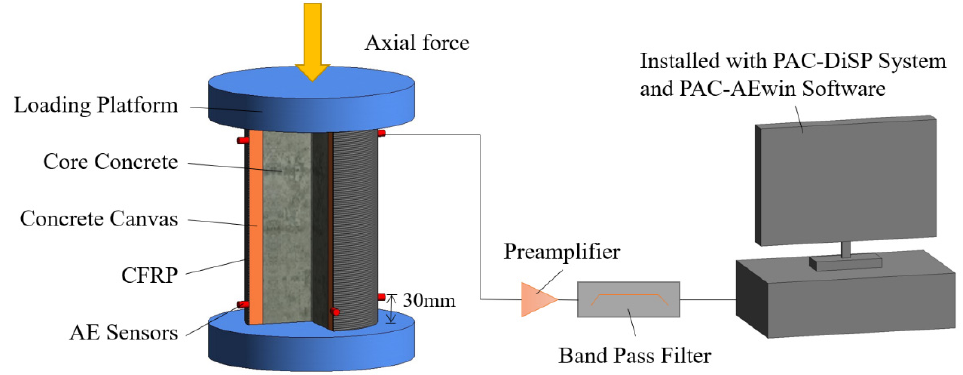
Figure 5. Schematic diagram of the AE acquisition system.